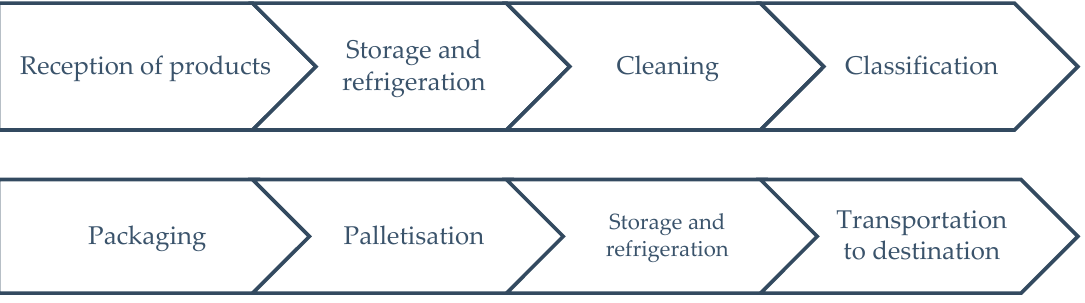
Figure 2. Handling process of horticultural products.